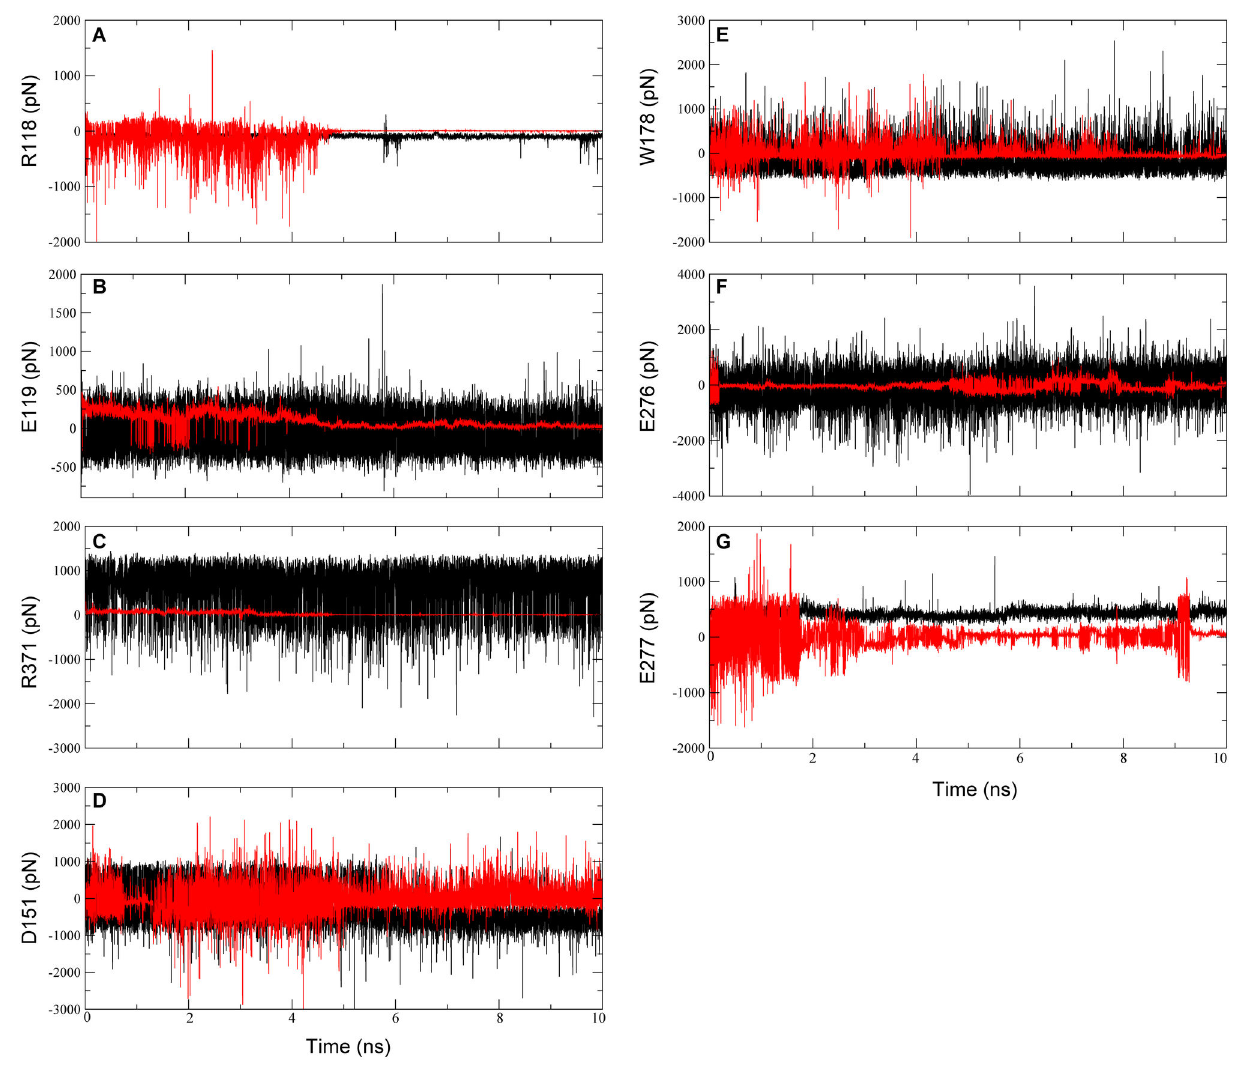
Figure 12. Force distribution analysis between the active site of 09N1 and ETT as well as ZMR. The forces between the active site of 09N1 and ETT are shown in red color curve, and the forces between ZMR and the active site are shown in black curve as a positive control. The pair-wise forces of other protomers and systems can be found in supporting information (Figures S2-S5).